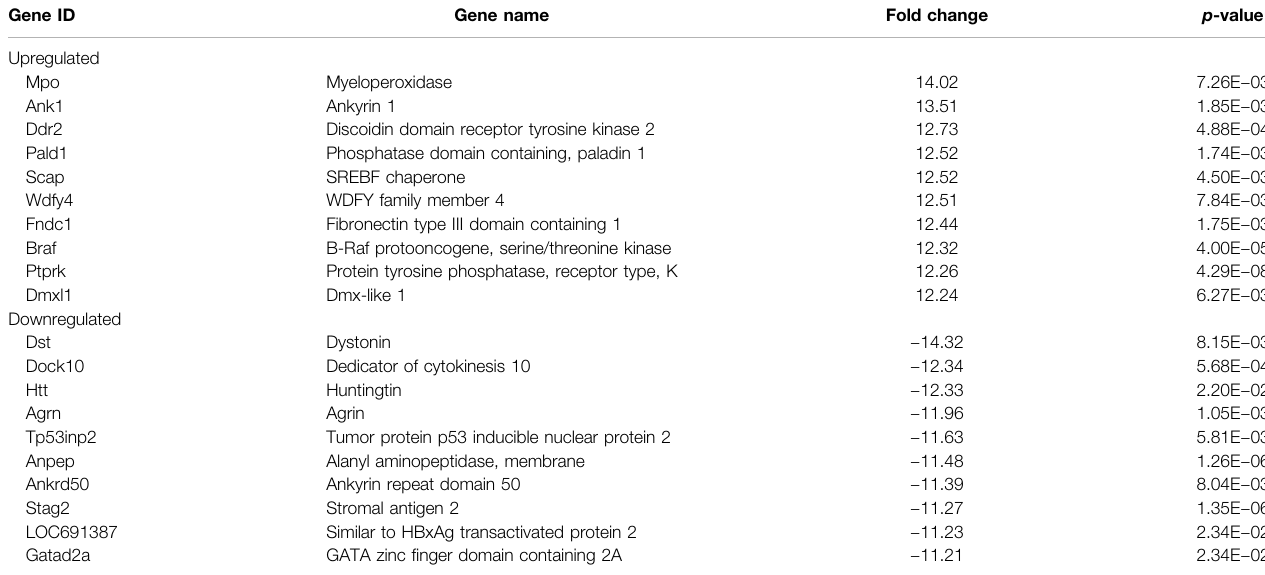
TABLE 3 | Top 10 upregulated and top 10 downregulated genes in Dipsacus asperoides ethanolic extract- (DAE-) treated rats. Gene